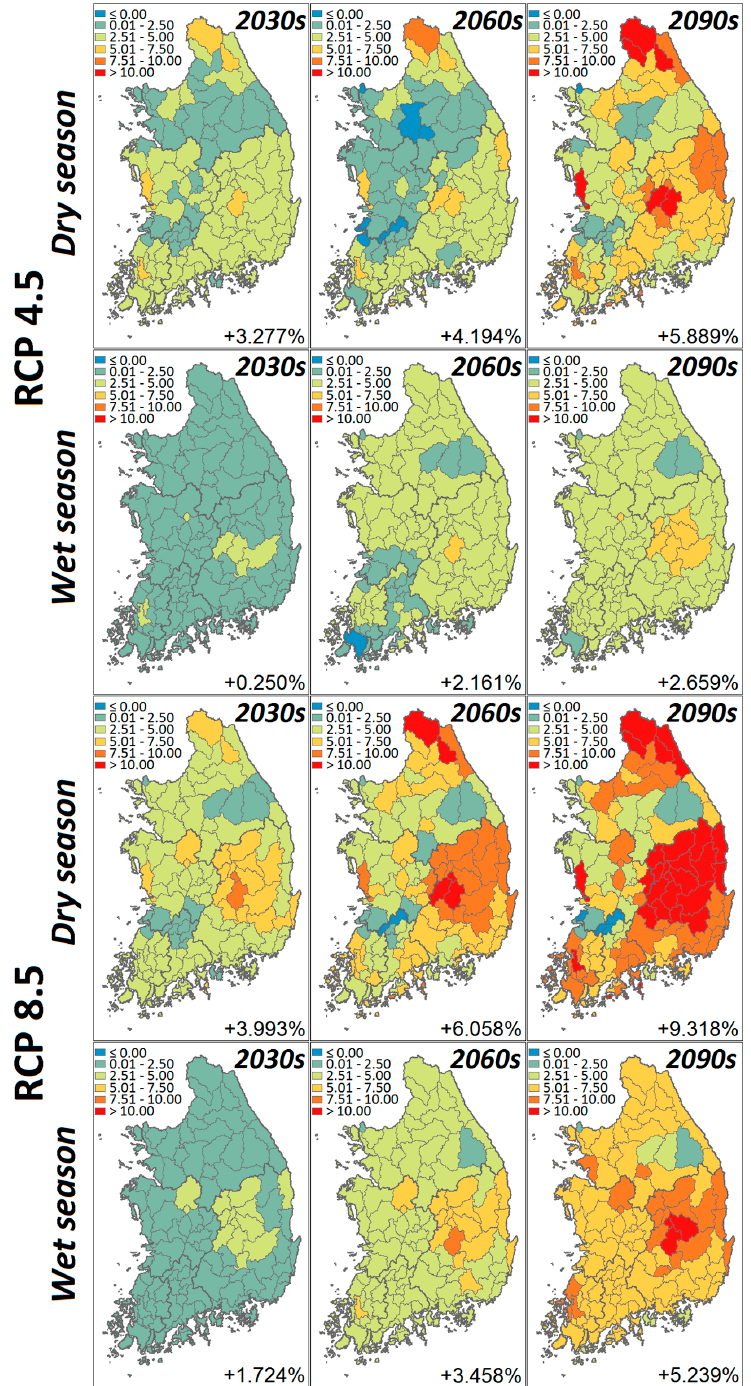
Figure 7. Spatial distribution of the runoff coefficient variation (%) in 3 future periods (2010–2039, 2040–2069, and 2070–2099) referred to the baseline (1976–2005) in South Korea during dry and wet seasons in RCP 4.5 and RCP 8.5. The values show the MME means of downscaled results averaged for 109